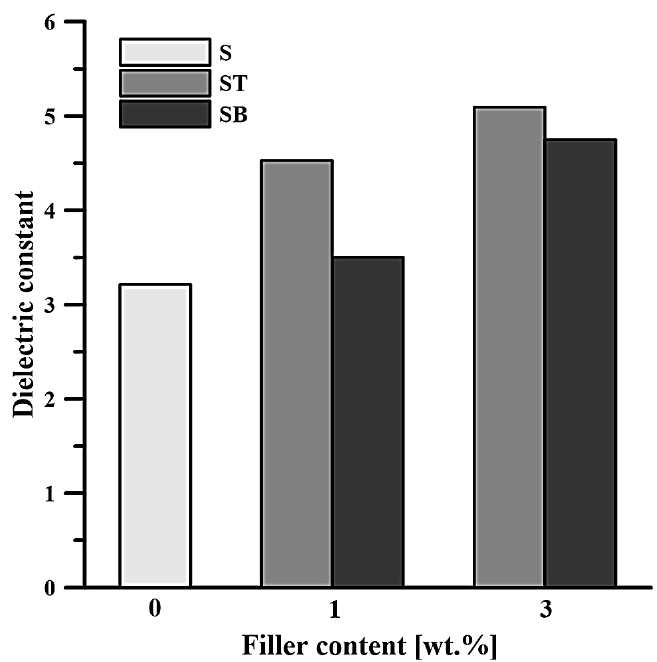
Figure 10. Comparison of dielectric constant for biosilica (SB) and talc (ST) modified poly(dimethylsiloxane) at 1